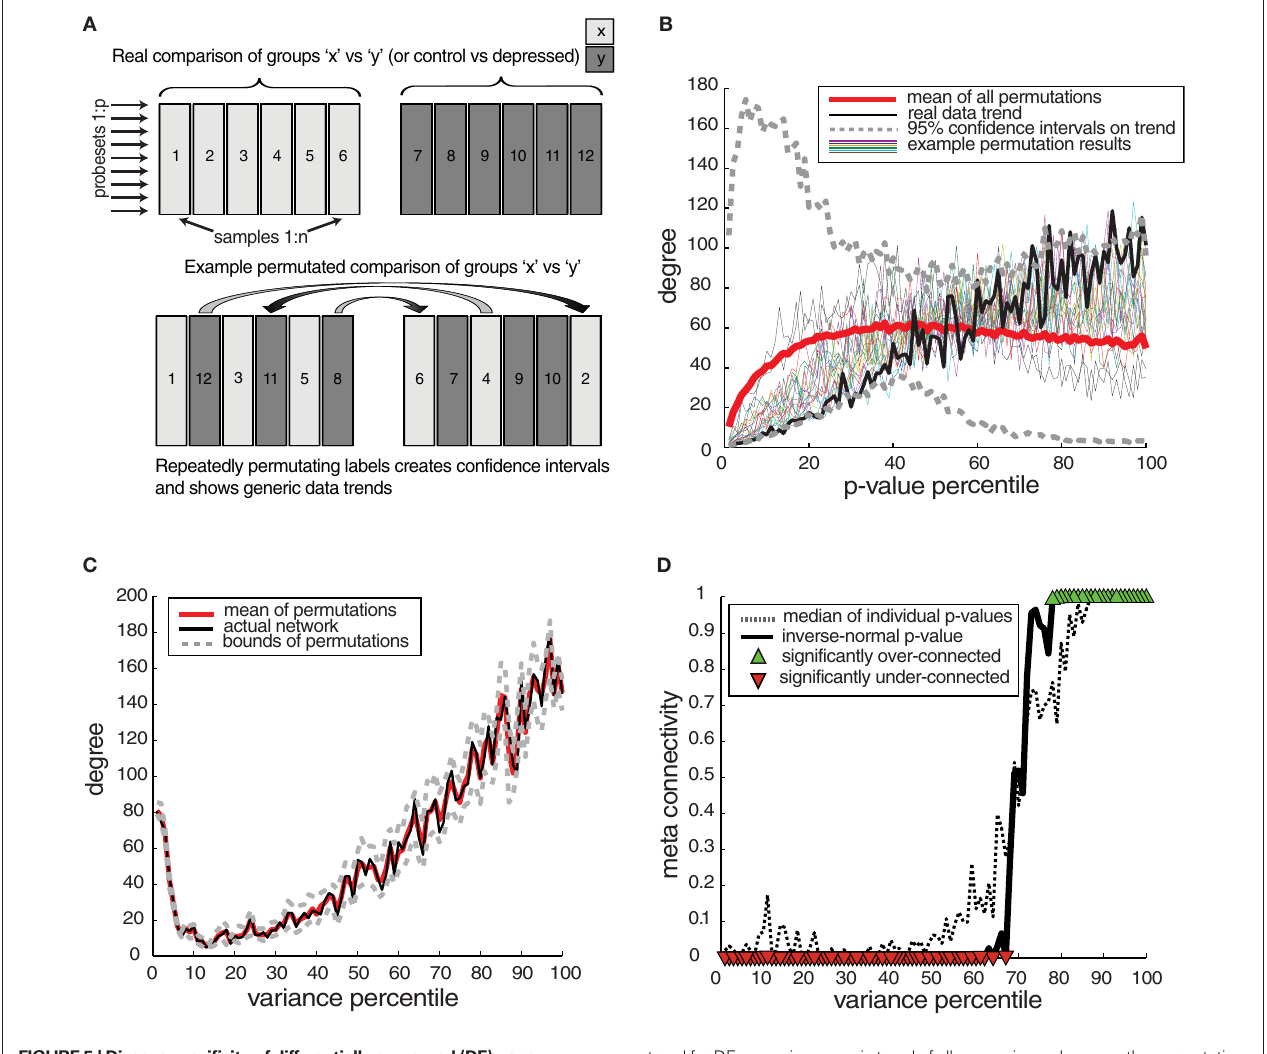
Figure 5 | Disease specificity of differentially expressed (De) gene connectivity patterns – example from human amygdala. (A) Schematic of method of data permutation to generate null comparisons, which contain no disease effect since control/disease samples are balanced. (B) Stereotypical and actual trends in connectivity by p -value, showing that the p -value-connectivity